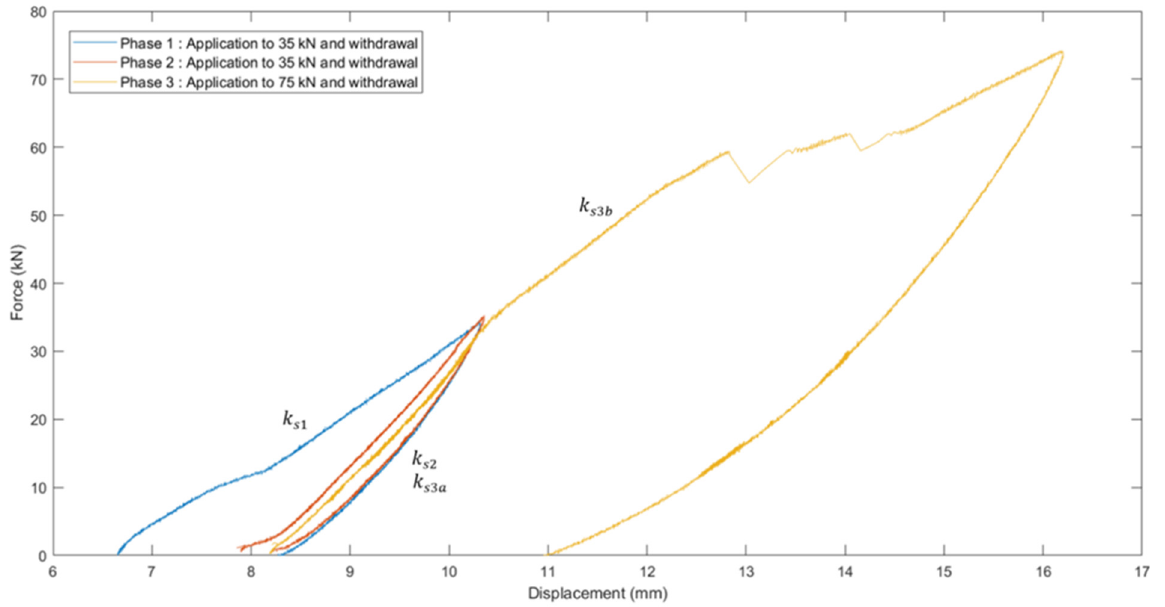
Figure 6. Shear loading, all phases of force application.